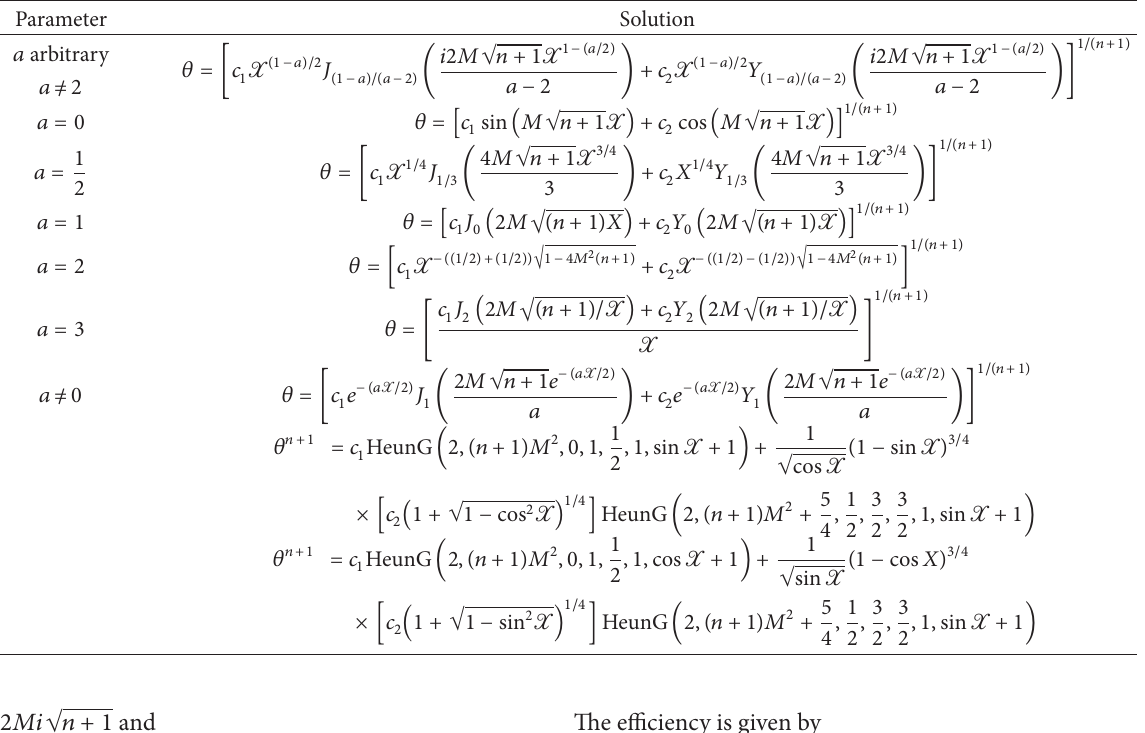
Table 4: Modified solution for 𝑓( X ) where X = 𝑥 + 1 , 𝑛 < −1 , and 𝑚 = 𝑛 ̸= − 1